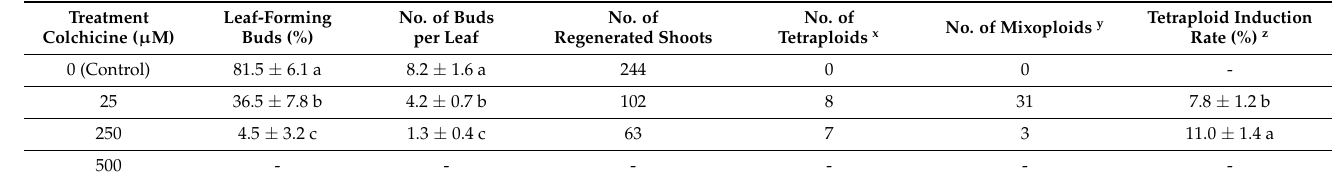
Table 1. Effect of colchicine concentration on somatic tissue chromosome doubling in Vaccinium corymbosum L. Data are presented as mean ± S.D. The means denoted by different letters are signifi- cantly different (Fisher’s test, p < 0.01). Data on oryzalin treatments have not been reported in the table as no regeneration has been